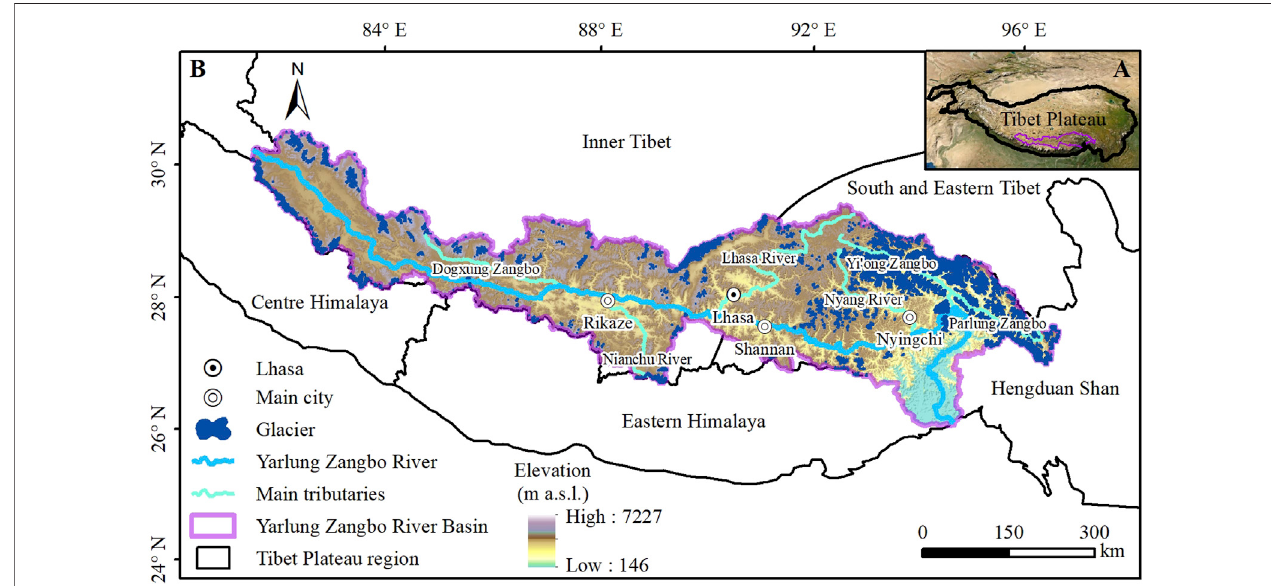
FIGURE 1 | (A) Location of the YZRB in relation to the Tibetan Plateau. (B) Overview of the distribution of glaciers in the YZRB.